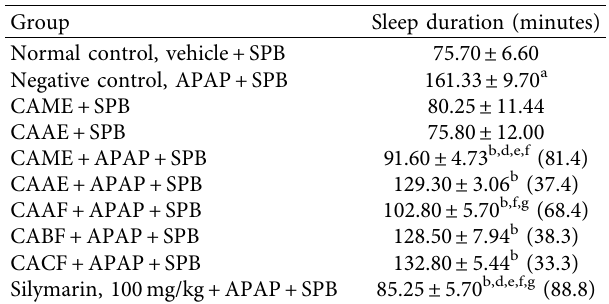
Table 5: Effects of high doses (400 mg/kg) of crude extracts and solvent fractions of methanol extract on SPB-induced sleeping time in rats orally administered 2g/kg APAP (mean ± SEM).